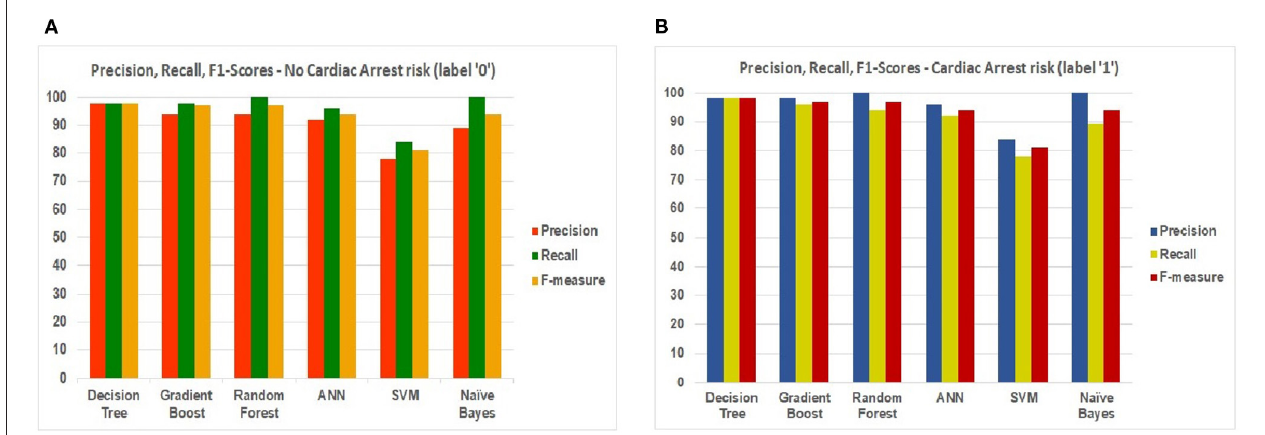
FIGURE 15 | ML models—Precision, Recall, and F1-scores—for (A) label “0” (B) label